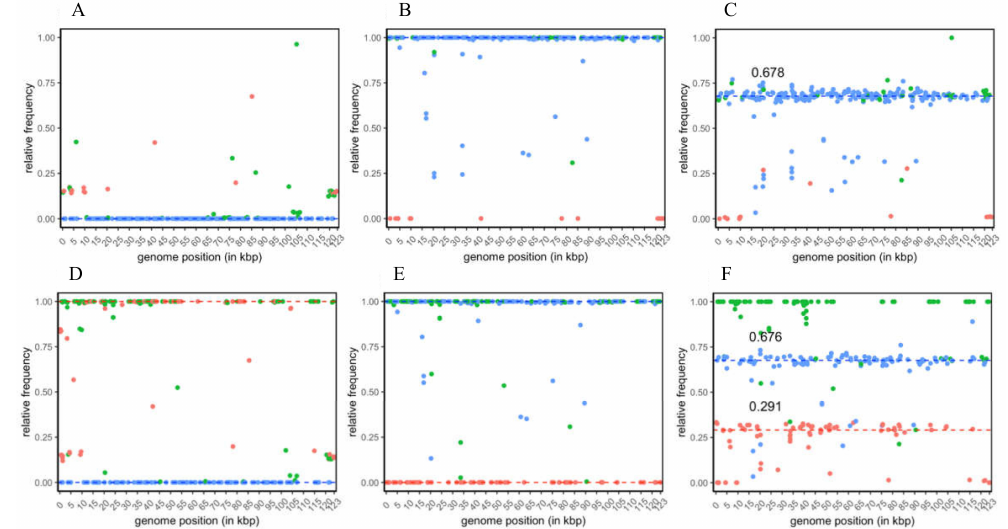
Figure 2. Single nucleotide frequency (SNP) plots of sequenced isolates CpGV-M ( A , D ), CpGV-S ( B , E ) and CpGV-0006 ( C , F ) mapped against reference sequences CpGV-M (KM217575) ( A – C ) and CpGV-E2 (KM217577) ( D – F ). For the CpGV-M and CpGV-E2 reference sequence-based analyses, 277 and 300 variable SNP positions were found, respectively, and the frequency of the alternative nucleotide was plotted (dots). The specificities of SNP positions were marked red for CpGV-M ( n = 15 and n = 82 for CpGV-M and CpGV-E2 reference based analysis, respectively), blue for CpGV-S ( n = 223 and n = 113 for CpGV-M and CpGV-E2 reference based analysis, respectively) and green for both isolates ( n = 39 and n = 105 for CpGV-M and CpGV-E2 reference based analysis, respectively). Median frequencies for CpGV-M and CpGV-S are indicated by red and blue dashed lines, respectively; numbers indicate the median frequency of CpGV-M and CpGV-S-specific SNPs in